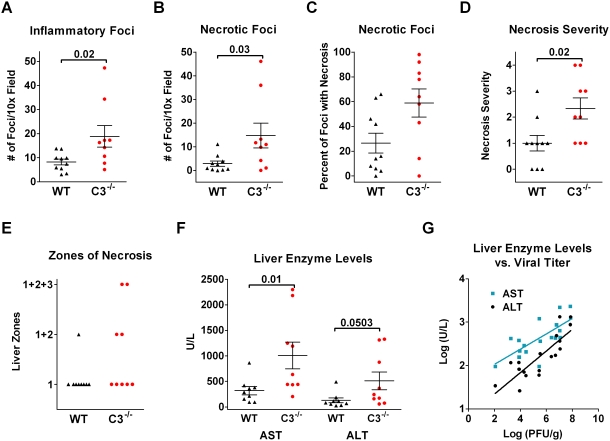
C3-deficient mice had a greater number of inflammatory foci with more extensive necrosis.(A–F) Wild-type (WT, black, ▴) and C3−/− (red, •) mice were compared, and P values are above the bracket. Error bars are SEM. (A) The number of inflammatory foci/visual field was counted. Each point represents the mean from ∼7 fields for an individual mouse. The graph plots the mean number of foci for each animal. (B) The number of inflammatory foci containing necrosis was counted and displayed as described in (A). (C) The percentage of foci that contained areas of necrosis. (D) The severity of the necrosis was quantitated using a 0–4 scale: 0, none; 1, piecemeal necrosis; 2, confluent areas of necrosis; 3, confluent areas of necrosis that extend beyond a single zone; and 4, bridging necrosis. (E) The zones of the liver (1, 2, and 3) where necrosis occurred. Zones are described in Figure 3A. (F) The serum levels of the liver enzymes in uninfected mice were <100 for AST and <50 for ALT. (G) AST (blue) and ALT (black) levels positively correlate with liver viral titer (r2 = 0.54 and 0.69, respectively). The log of these parameters for both C3−/− and wild-type mice was used for linear regression.